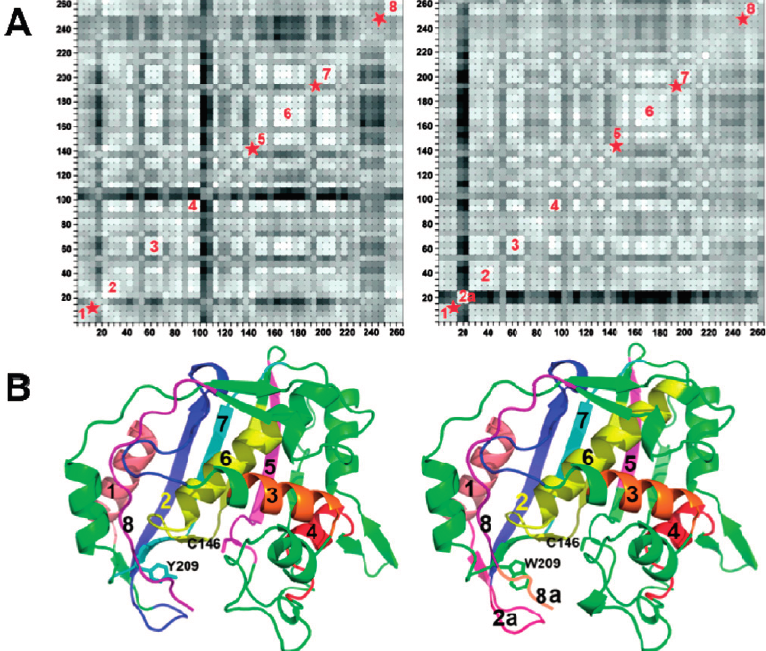
Figure 2. ( A ) The residue-based matrix plots showing correlations of anisotropic B-factor displacements for Escherichia coli TSase ( ec TSase) atom pairs identified by the ( x , y ) grid coordinates of the plot. The left plot is for the WT ec TSase and the right plot is for Y209W ec TSase (Reproduced from [14] with permission from the American Chemical Society (ACS)). The degree of correlation is represented by color-coding, where the lighter shades of grey indicate greater correlation. The blocks of light-colored squares along the diagonals of the plots indicate the protein residues that vibrate as rigid bodies. The red stars indicate segments with disrupted rigid body vibrations of the Y209W mutation. Segment 2A in the right plot is the phosphate-binding loop with relatively higher B factors; ( B ) Ribbon diagrams of WT ( left ) and Y209W ( right ). The segments labeled in ( A ) are colored. The cofactor analog (CB3717), dUMP and the mutated residue and catalytic cysteine are shown as sticks. Segment 8A represents the C -terminal. (adapted from [15] with permission from the